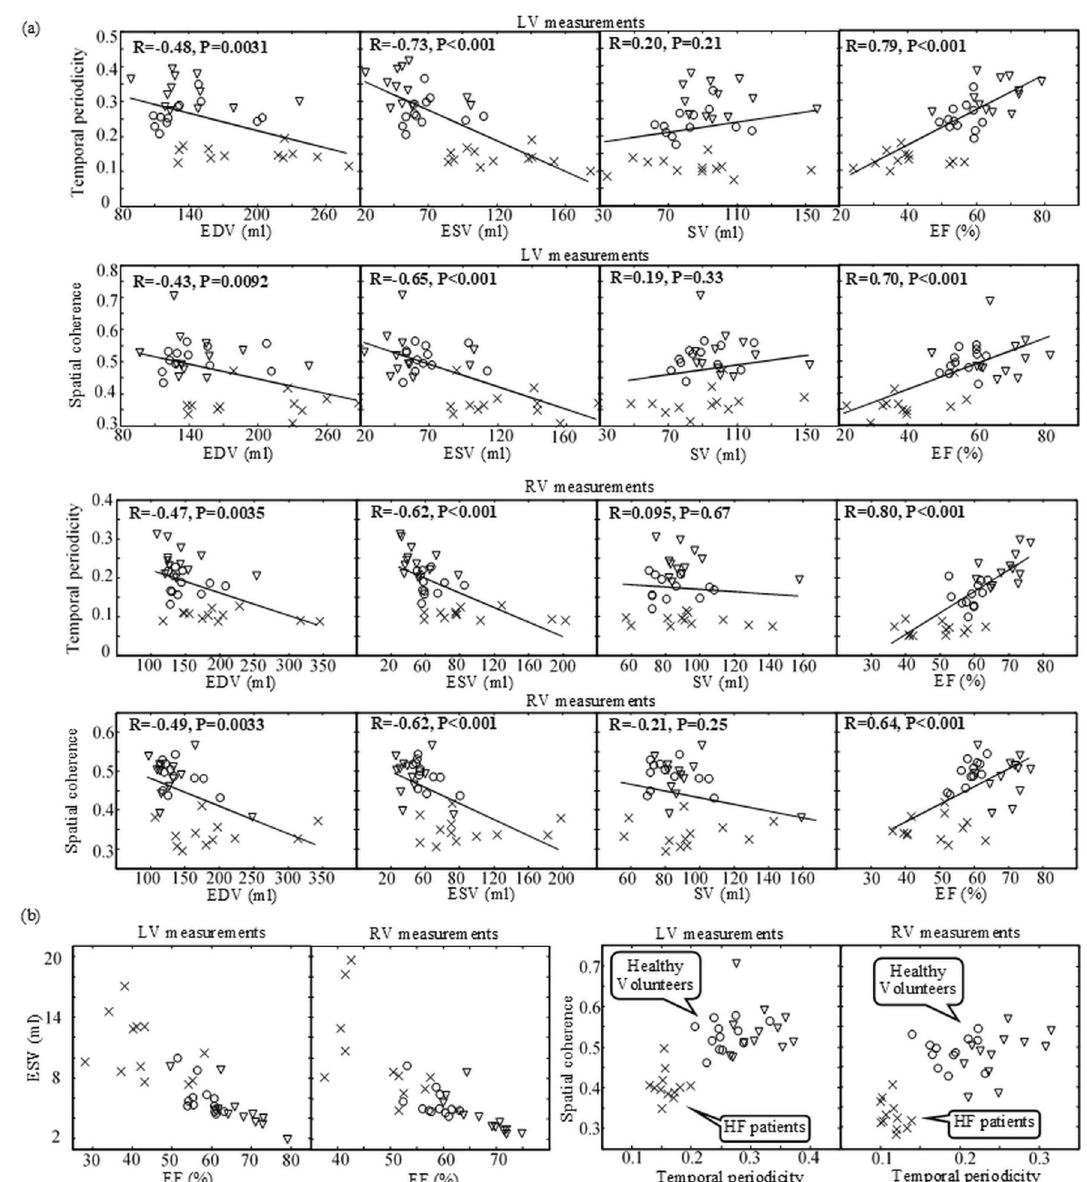
Figure 5. ( a ) Pearson correlation coefficients between temporospatial indices (temporal periodicity and spatial coherence) and volumetric indices (EDV, ESV, SV and EF) in LV and RV. ( b ) Scatter plots of volumetric indices (ESV vs. EF) and those of temporospatial indices (spatial coherence vs. temporal periodicity). The measurements in the healthy volunteers at rest and during exercise are represented respectively with “o” and “ ∇ ”, and those in the HF patients with “× Comparison of temporospatial and volumetric indices. Figure 5(a) provides the Pearson correlation coefficients between the temporospatial indices (temporal periodicity and spatial coherence) and the volumetric indices (EDV, ESV, SV and EF). The temporospatial indices were most correlated to EF (R = 0.64–0.80). They were strongly correlated to ESV (R = 0.62–0.73). Their correlation with EDV, although not high, exists (R = 0.43– 0.49). There was no considerable correlation with SV in all the cases (R < 0.30). Figure 5(b) provides the scatter plots of spatial coherence vs. temporal periodicity in reference to those of ESV vs. EF. The HF patients and healthy volunteers were clearly separated in the scatter plots of temporospatial indices while they were mixed in those of volumetric indices. We recorded the post-processing time for measuring temporal periodicity and spatial coherence in real-time images. The most time-consuming procedure was image segmentation for ROI determination in the LV and RV. This manual procedure required 10–20 min for each subject depending on the quality of real-time images. After ROI determination, the time cost of automatic index computation was ~ 2 s on a computer with Intel (R) Core (TM) i7-6700 CPU 3.40 GHz and 32 GB memory. In comparison, volumetric measurements with